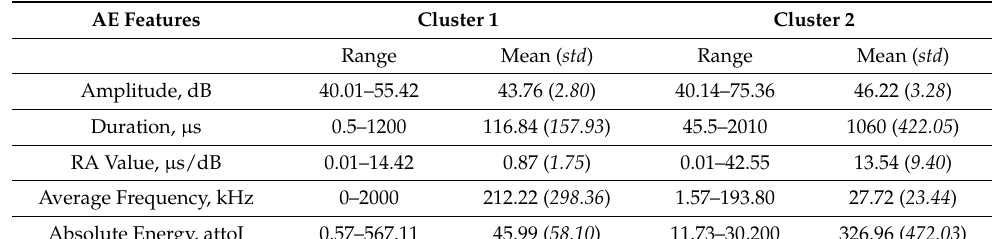
Figure 9. Clustering solutions for abrasive wear showing ( a ) duration vs. amplitude and ( b ) hits vs. amplitude plots. Table 4. Range and mean (including standard deviation) values of five features per cluster for abrasive wear test.